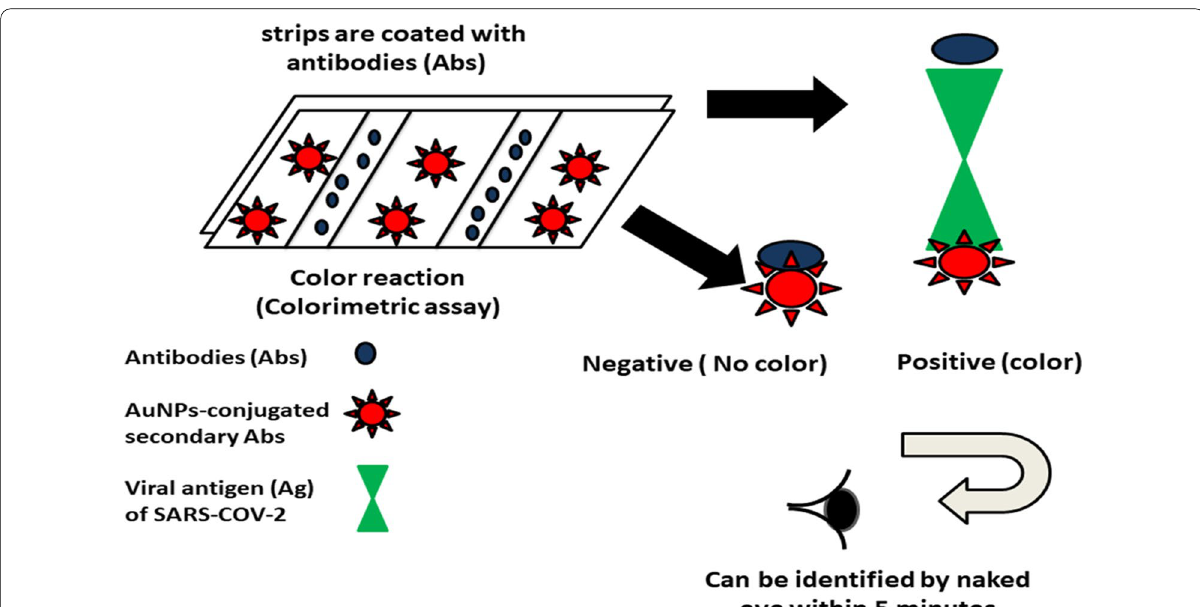
Fig. 2 Schematic illustration represents the AuNP-based strips for the colorimetric detection of severe acute respiratory syndrome (SARS). Strips are coated with antibodies (Abs) that are capable of binding to viral antigen (Ag) of SARS-COV-2, that subsequently aggregate with AuNPs-conjugated secondry Abs. This aggregation results in color reaction, indicating the positivity of the tested